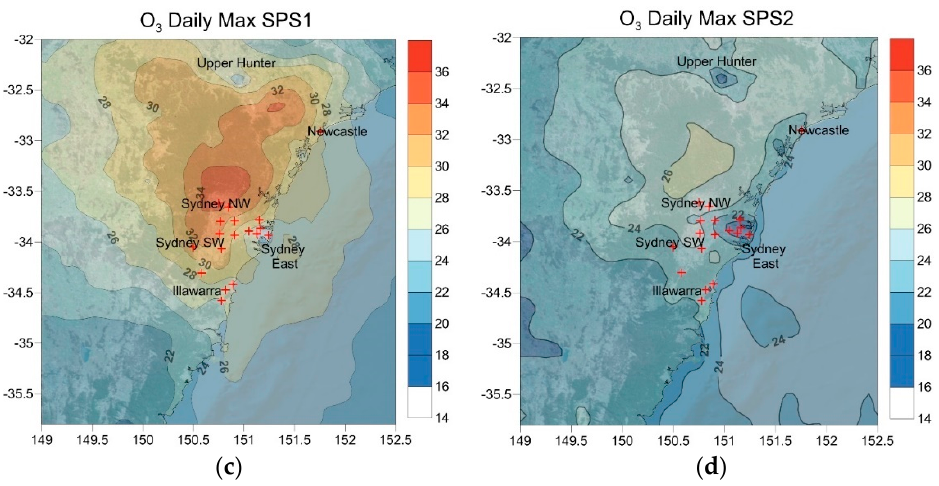
Figure 11. Spatial distribution of O 3 concentrations (ppb) predicted by CCAM ‐ CTM with GMR 9 ‐ km horizontal resolution domain. The hourly average O 3 concentrations for the period of ( a ) SPS1 and ( b ) SPS2; and the average of O 3 daily maximums for the period of ( c ) SPS1 and ( d ) SPS2. Red cross signs indicate locations of OEH stations.